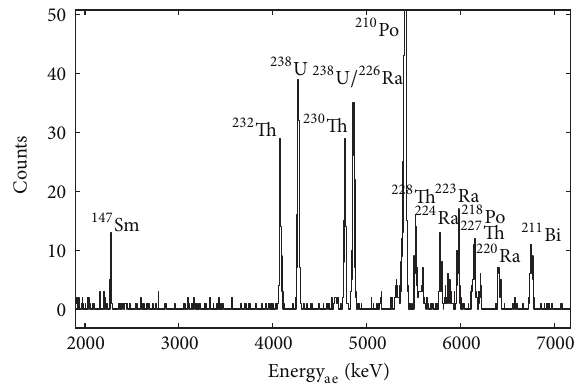
Figure 8: Energy spectrum of bulk alpha events in a background